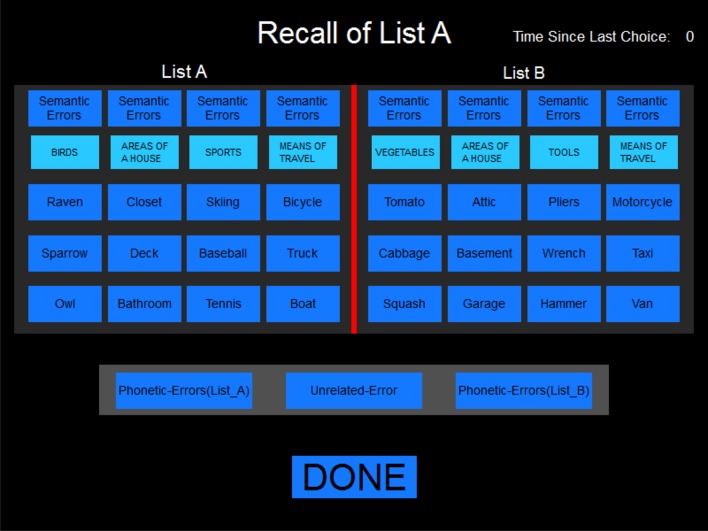
The scoring display. The display as it appeared to the examiner during the immediate free recall of List A and after the presentation of List B. Only List A tokens were displayed during the first three presentations of list A.